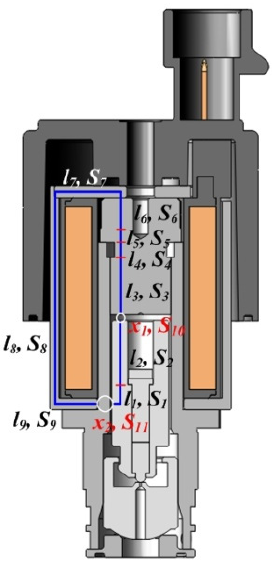
Figure 6. Probable flux path.